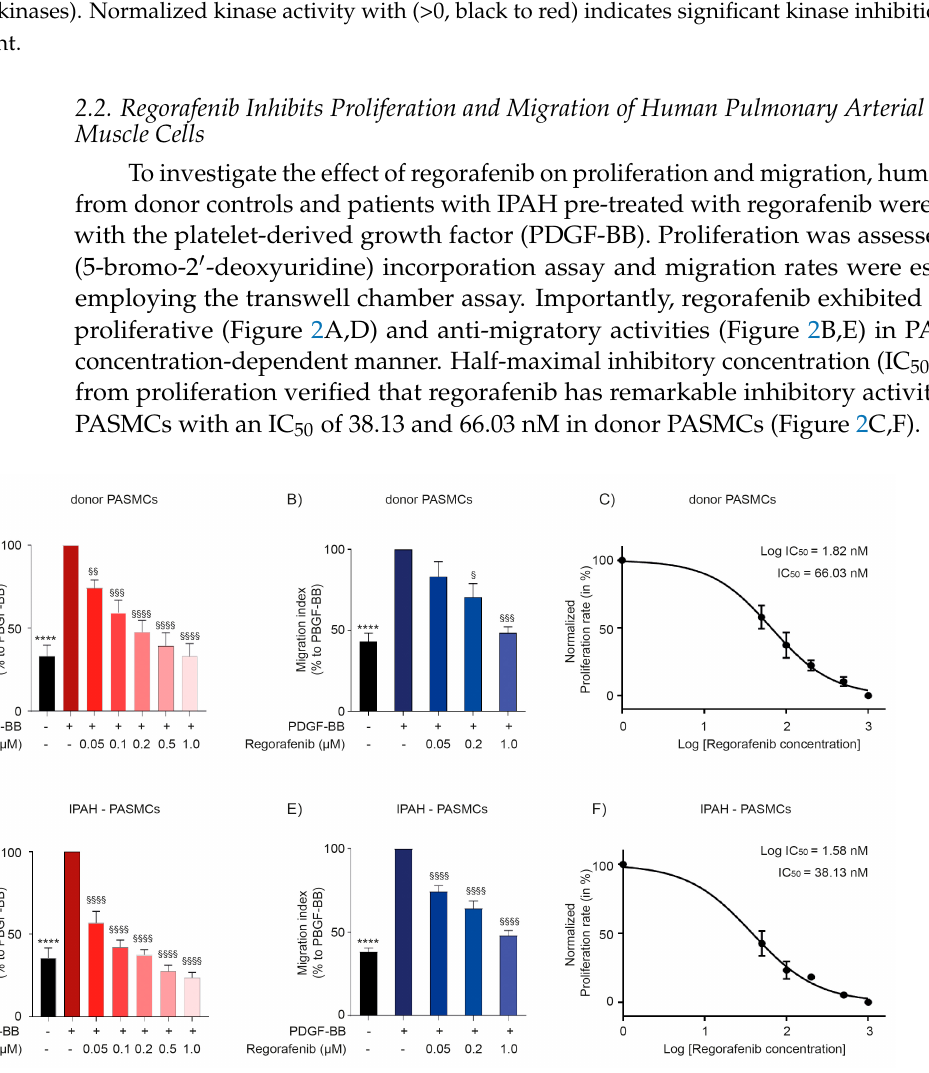
kinases in IPAH-PASMCs (29, highlighted in green) and regorafenib treated IPAH-PASMCs (23, highlighted in red) as well as an intersecting set of candidates. ( D ) The graph representing 15 overlapping kinases (on X -axis) activated in IPAH-PASMCs (in green) and their inhibitory pattern by regorafenib treatment (in red), AU: Arbitrary units. ( E ) Representation of 15 kinases (regorafenib-mediated inhibition in IPAH-PASMCs) in the phylogenetic kinome tree containing the following groups: TK (tyrosine kinase), TKL (tyrosine kinase-like), AGC (protein kinase A, G, C families), CAMK (calcium/calmodulin-dependent protein kinase), CK1 (casein kinase 1), CMGC (CDK, MAPK, GSK3, CLK families) and STE (homologs of yeast Sterile 7, Sterile 11, Sterile 20 kinases). Normalized kinase activity with (>0, black to red) indicates significant kinase inhibition with regorafenib treatment.